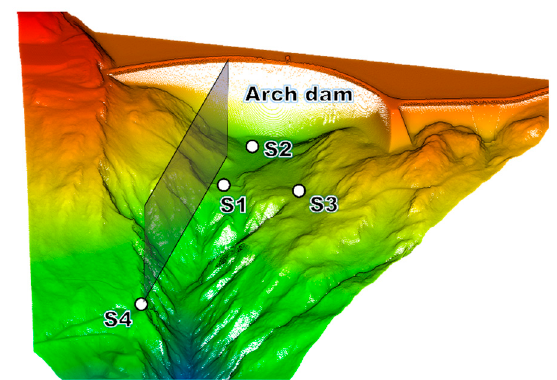
Figure 4. TLS station points and vertical section on digital terrain model (DTM) (Source for DTM: LiDAR Data obtained from Land Vorarlberg, Austria—data.vorarlberg.gv.at).